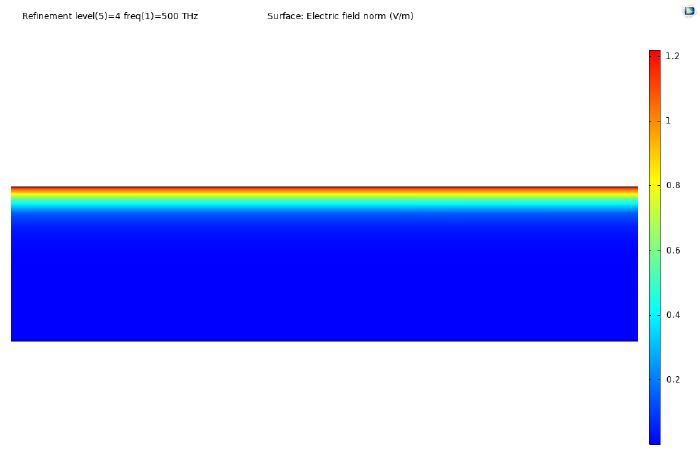
Figure A4. Electric field norm of Ga 0.66 In 0.34 As at 200 THz and 500 THz.